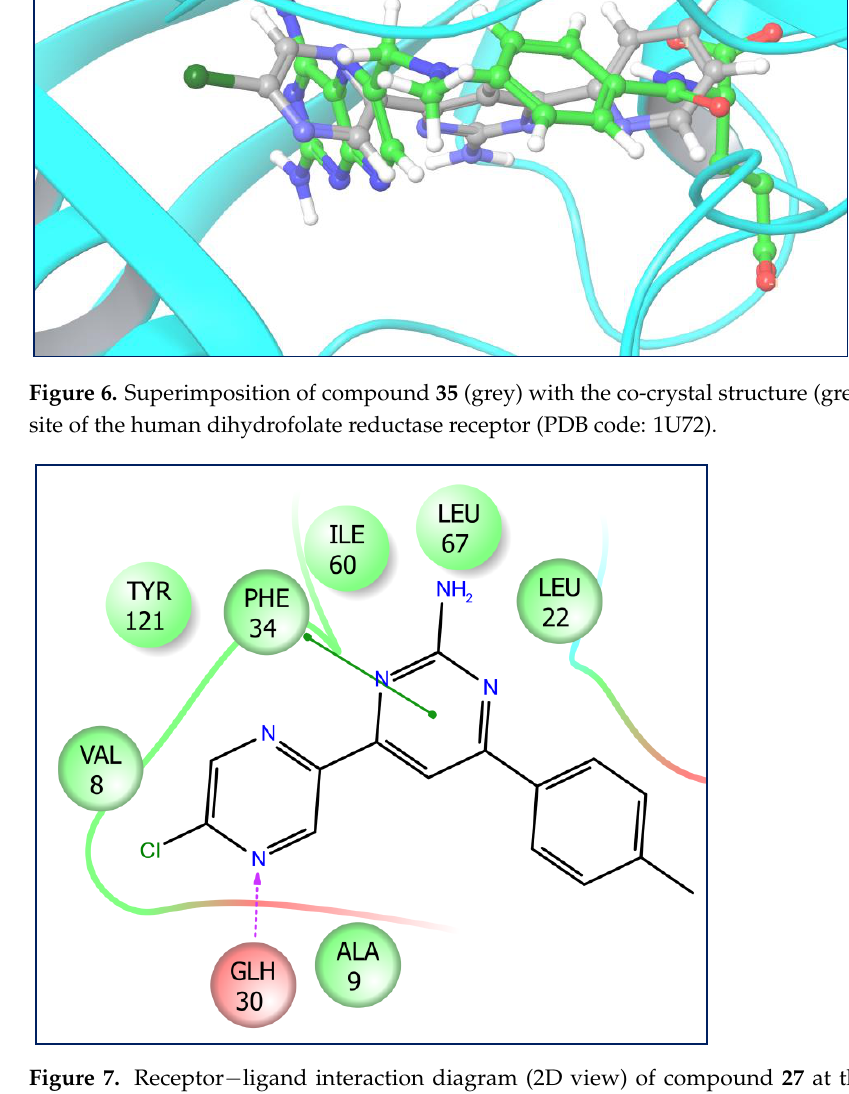
Figure 6. Superimposition of compound 35 (grey) with the co-crystal structure (green) at the active site of the human dihydrofolate reductase receptor (PDB code: 1U72).